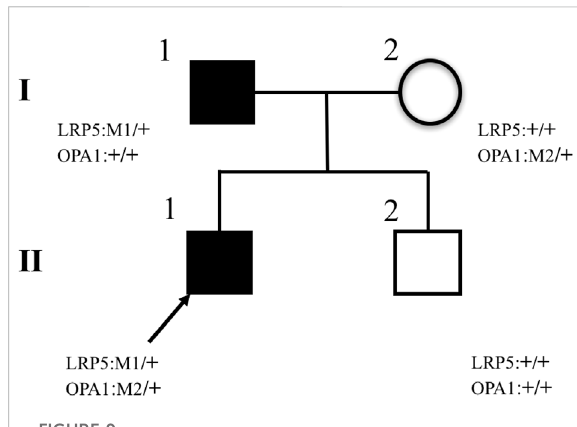
FIGURE 9 Pedigrees of families. The II – 1 proband is marked with an arrow and has two missense heterozygous mutations, LRP5 (c.2551C > T, p .His851Tyr) and OPA1 (c.565G > A, p .Glu189Lys). Pedigree veri fi cation analysis shows that the proband ’ s father has a heterozygous mutation of LRP5 (c.2551C > T, p .His851Tyr) (I – 1), the proband ’ s mother has a heterozygous mutation of OPA1(c.565G > A, p .Glu189Lys) (I – 2), and the proband ’ s fraternal twin brother has no mutation (II –